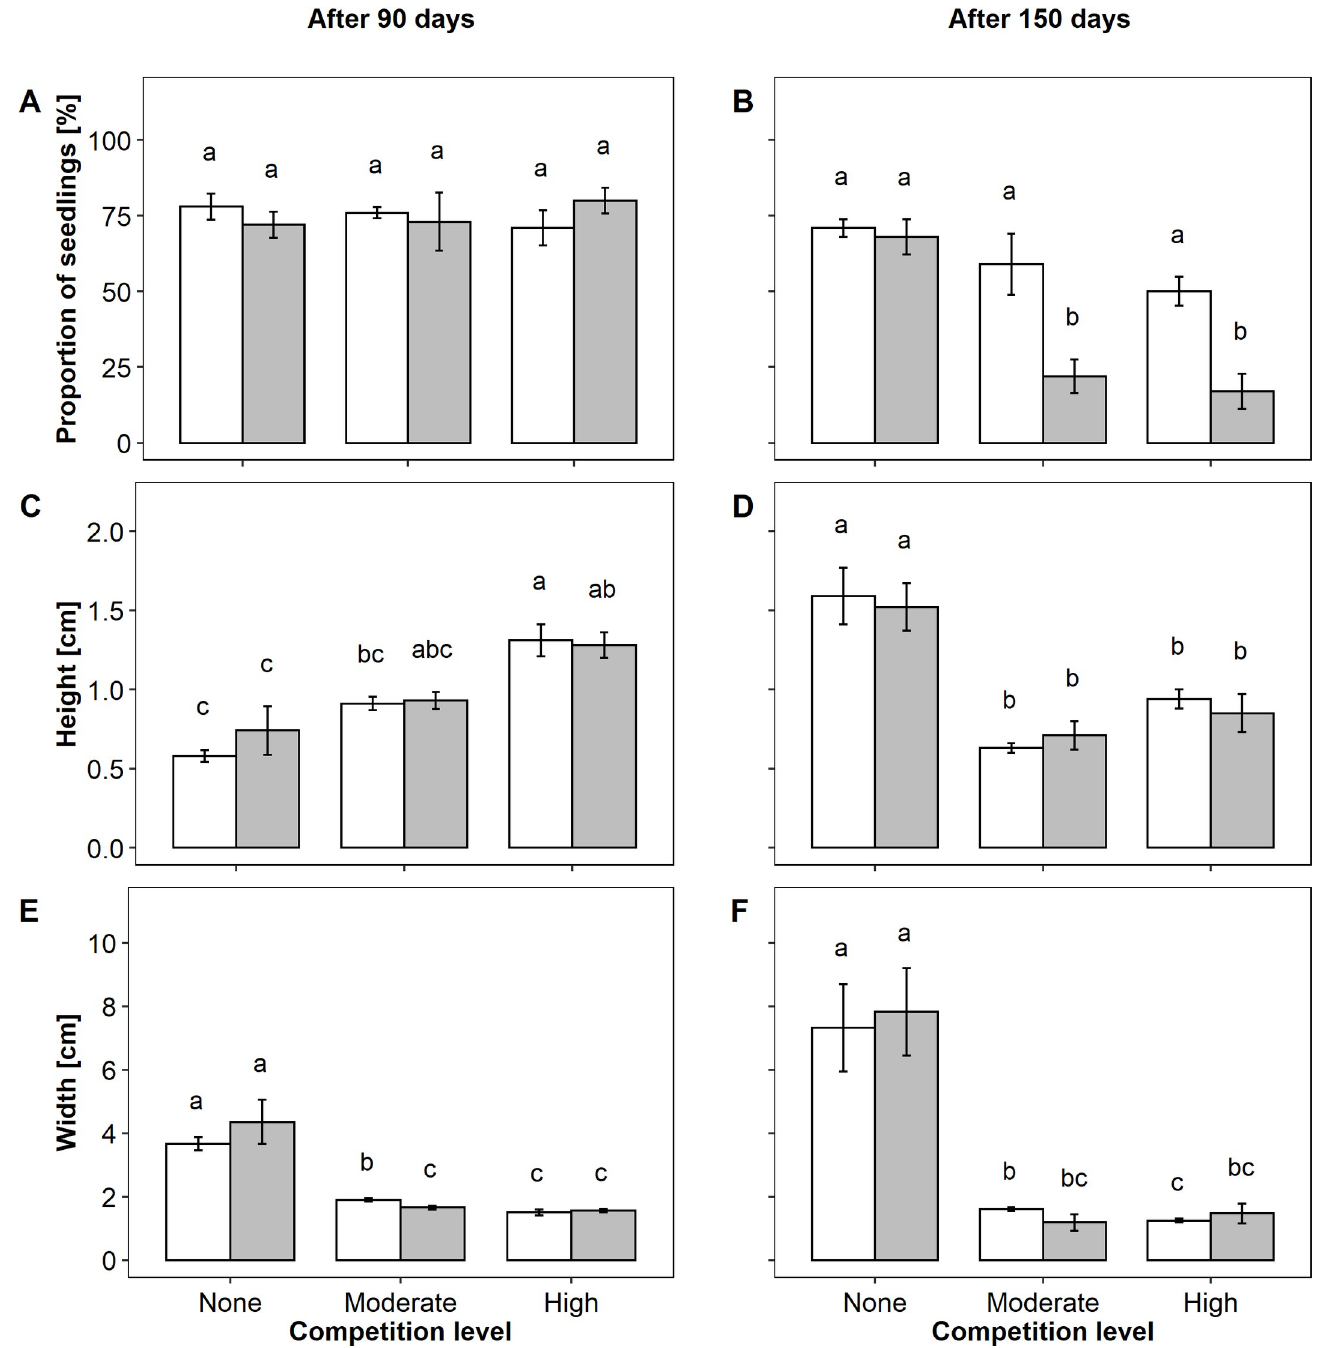
Fig 5. Response of A . montana seedlings to competition and N fertilization. Mean proportion of seedlings (A, B), height (C, D) and width (E, F) of rosettes for the competition levels (none, moderate, high) and the N fertilization levels (without fertilizer (white), with fertilizer (gray)) ( ± SE). Fig 5A, 5C, and 5E display the results after 90 days following sowing, whereas B, D, and F show the measurements after 150 days. Different letters indicate significant differences between treatment combinations; separately for the two sampling points (p < 0.05).